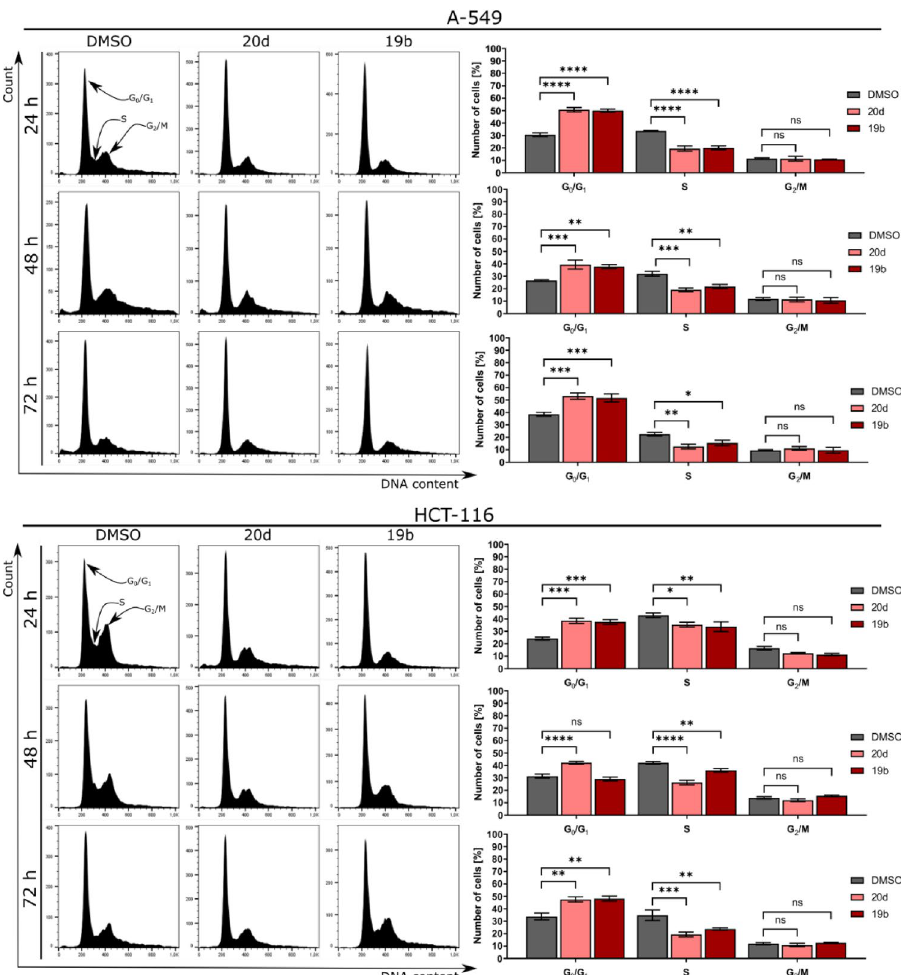
Figure 5. Cell cycle analyses. Representative histograms after DNA staining are presented in left panels. Statistical analyses of histograms are presented on right panels. Error bars show the SEM of data obtained in three independent experiments. Statistical differences were analyzed with a one-way ANOVA post-hoc Dunnet’s test. ns p > 0.05, *p < 0.01, **p < 0.001 ***p < 0.0001 vs.